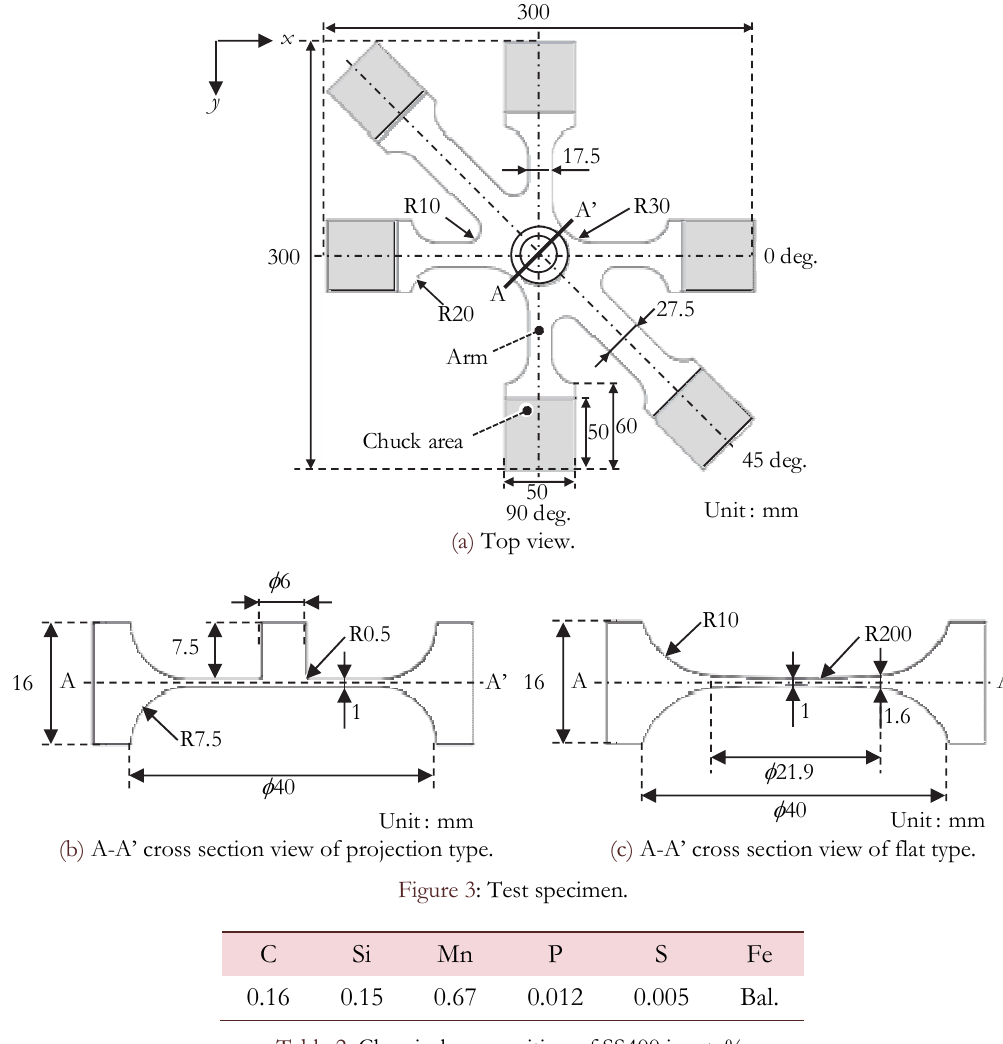
Table 2: Chemical composition of SS400 in wt. %.